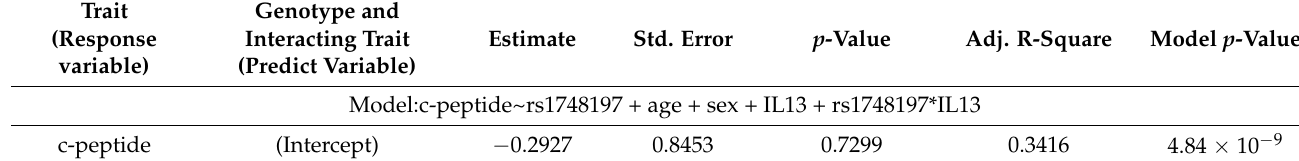
Table 4. Linear regression model illustrating the link between the rs1748197 and interaction of c-peptide with IL13 or of irisin with TG. Results are shown for carrier genotypes (GA and AA) regressed against the reference GG genotype.